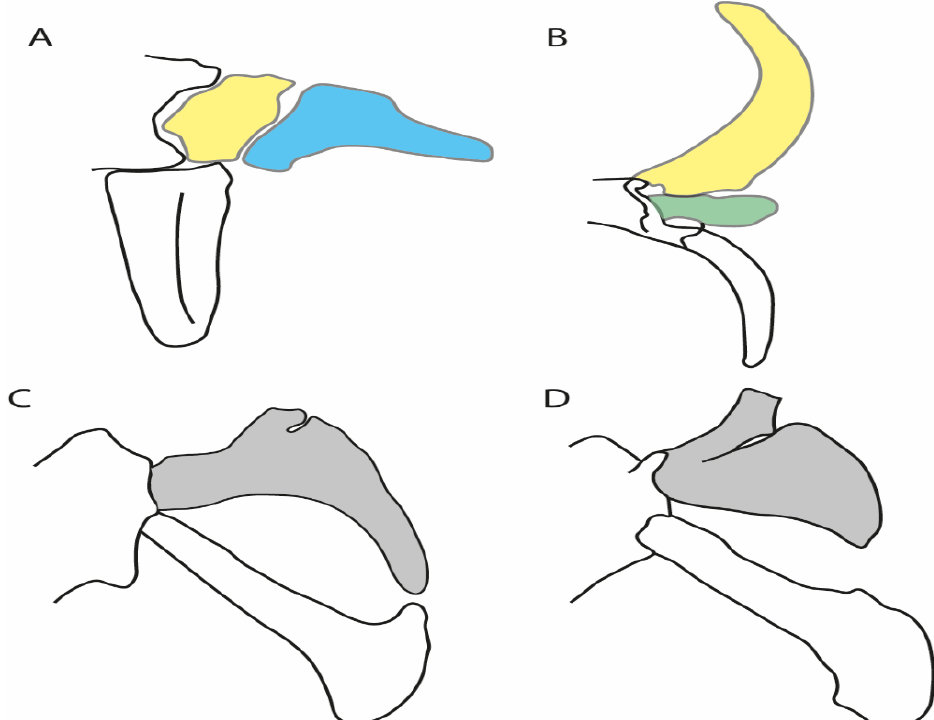
Figure 45. Scapulacoracoid and basal pectoral elements in dorsal and ventral views. State (0): ( A ) Chimaera cubana (USNM 400700, https://sharksrays.org/ (accessed on 25 March 2020)). State (1): ( B ) Rhinobatos glaucostigma (CNPE IBUNAM 17810). State (2): ( C ) Hemiscyllium ocellatum (USNM 40024) redrawn and modified from da Silva and de Carvalho Text-Figure 3F in [8]; ( D ) Ginglymostoma cirratum (CAS 232210) redrawn and modified from da Silva and de Carvalho Text-Figure 10F in [8]. Colors: propterygium in yellow; mesopterygium in green; anterior radial element in blue; and fusion between propterygium and mesopterygium in gray.